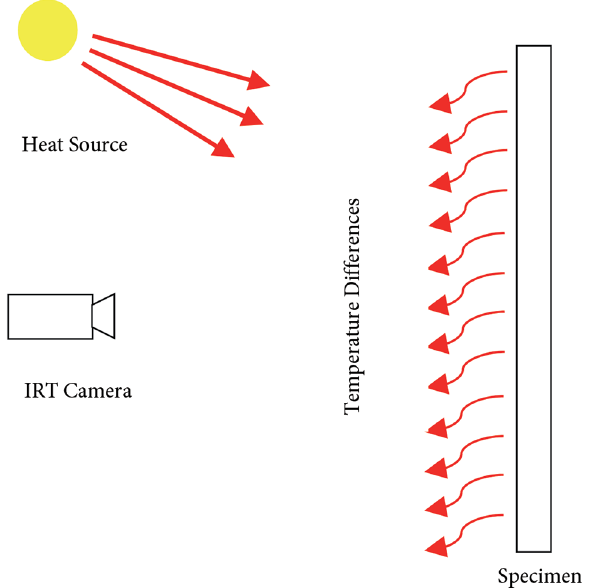
Figure 1. Typical arrangement of equipment for flash